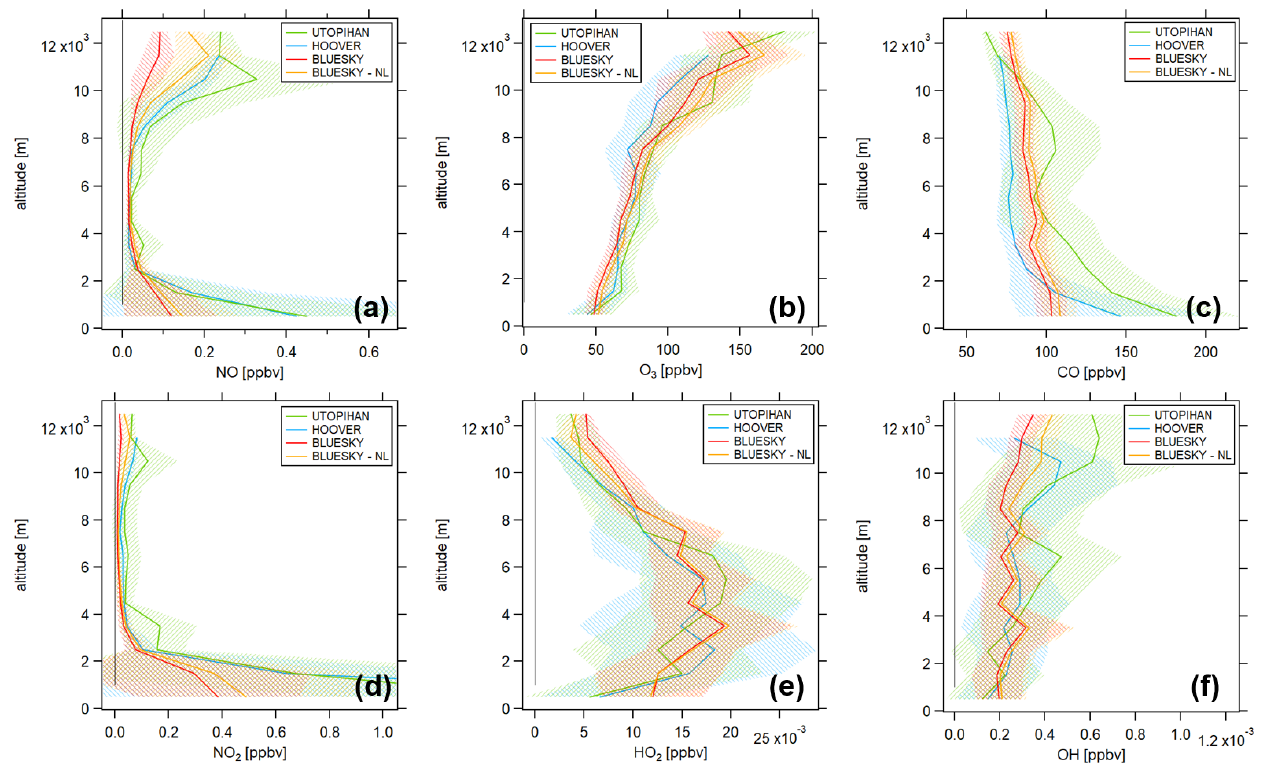
Figure 3. Vertical profiles of the atmospheric trace gases (a) NO, (b) O 3 , (c) CO, (d) NO 2 , (e) HO 2 and (f) OH for the campaigns UTOPI- HAN (green), HOOVER (blue) and BLUESKY (red) and the no-lockdown (NL) scenario (yellow). All data shown here are from EMAC model simulations along the flight track of each research campaign. Two separate simulations were run on the flight path of BLUESKY, one with lockdown and one with business-as-usual emissions. The shaded areas represent the 1 σ standard deviation from averaging the data points at each altitude bin. The numbers of data points averaged per altitude bin are displayed in Table